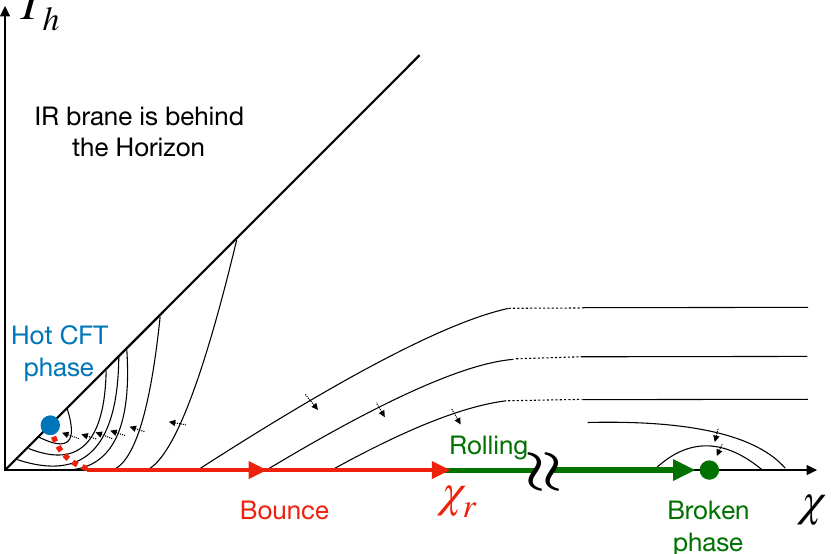
Figure 3 . A 2D illustration of the effective potential describing both phases of the CFT: the spontaneously broken phase parametrized by the dilaton, χ , and the hot conformally-restored phase parametrized by the horizon Hawking temperature of the 5D black brane dual. χ = 0 corresponds in the RS picture (i.e. the spontaneously broken phase) to the IR brane at infinity. Conversely, the AdS- S geometry, dual to the hot CFT phase, is truncated at the horizon and the IR brane can be thought of sitting there and contributing no energy due to the vanishing warp factor. We stress that T h is not a canonical degree of freedom nor is it parametrically lighter than any other excitation in that phase. Consequently the (multi-dimensional) potential is unknown in this regime. Furthermore, in the spontaneously broken phase, the effective theory breaks down for χ < T max[1 , k/M ∗ ] , where additional KK modes are expected to enter and/or non-calculable quantum gravity corrections must be taken into account. Below the critical temperature, the spontaneously broken phase lies parametrically farther from the origin in field space compared with the hot CFT minimum, since the relevant scale in the latter phase is the temperature T . This fact plays a role in the calculation of the bounce action, which for sufficiently large temperatures is dominated by the semi-classical contribution from the broken phase. The red line shows the path of an effective euclidean particle tunneling from the false vacuum to the true one. The solid part describes the dominant and calculable contribution while the dotted part illustrates the non-calculable but subdominant part of the action for χ r > T max[1 , k/M ∗ ] , where χ r is the release point of the bounce. The green line illustrates the Lorentzian-time path of the field, as it rolls down to the minimum of the broken phase after